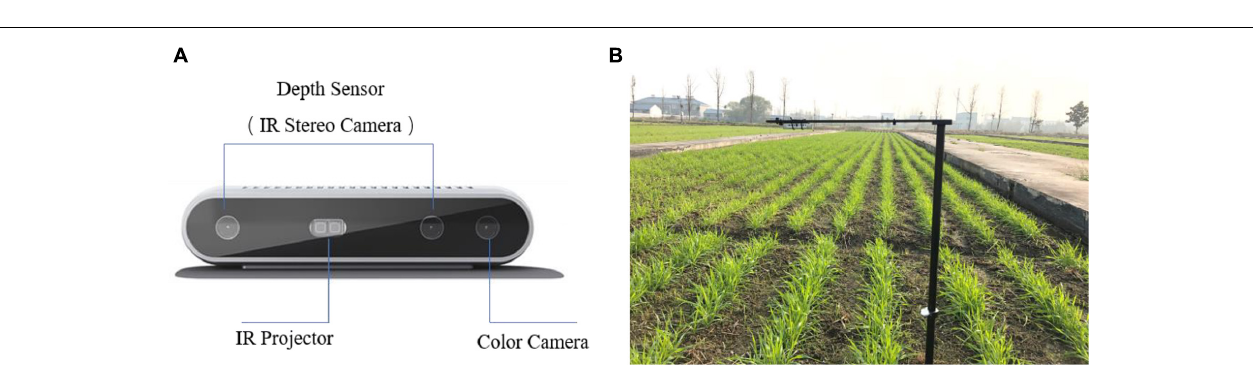
FIGURE 2 | (A) Intel RealSense D415; (B) Equipment setup for field image acquisition.